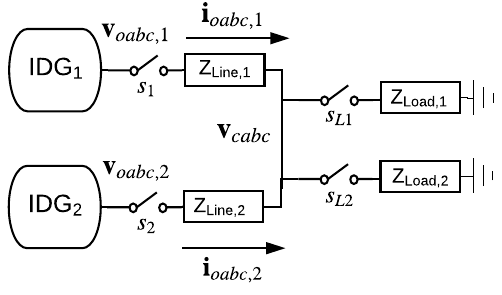
Figure 1. MG architecture.